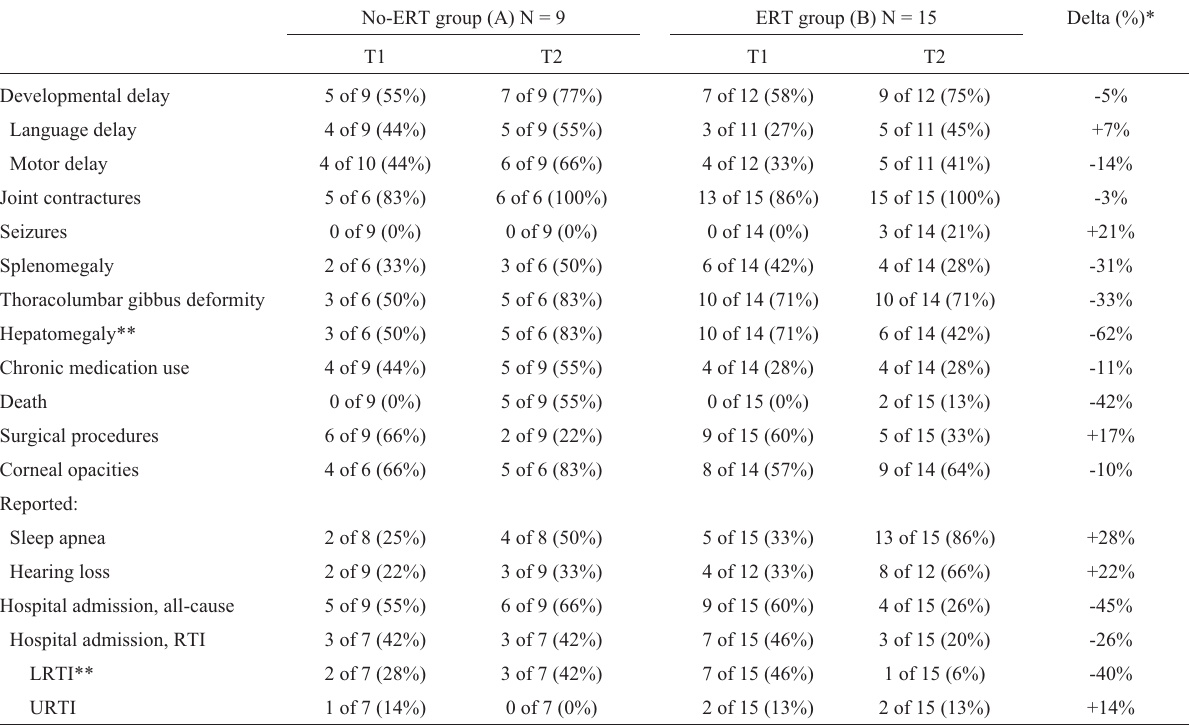
Table 3 - Enzyme replacement therapy for mucopolysaccharidosis type I: comparative analysis of clinical variables between T1 and T2 (n = 24).